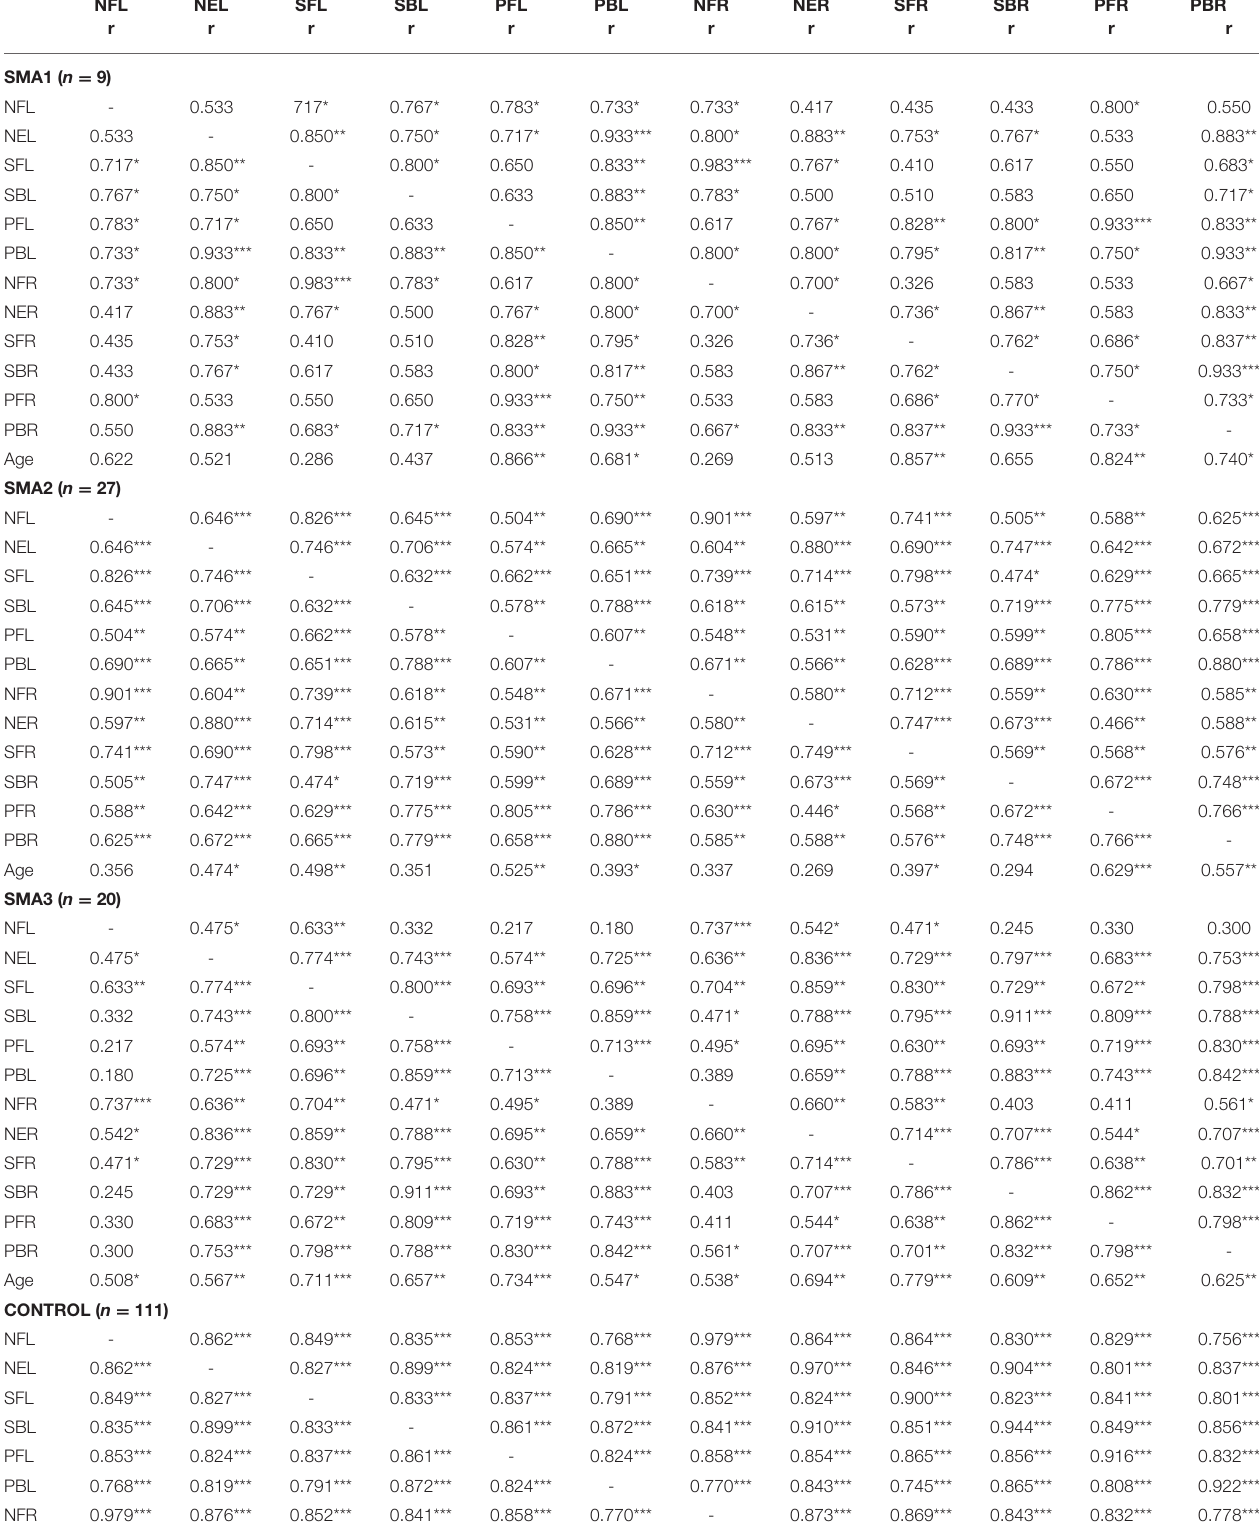
TABLE 3 | The Spearman rank correlation coefficient (r) for the T torque values and age within SMA1, SMA2, SMA3, and control groups aged 5–16. NFL